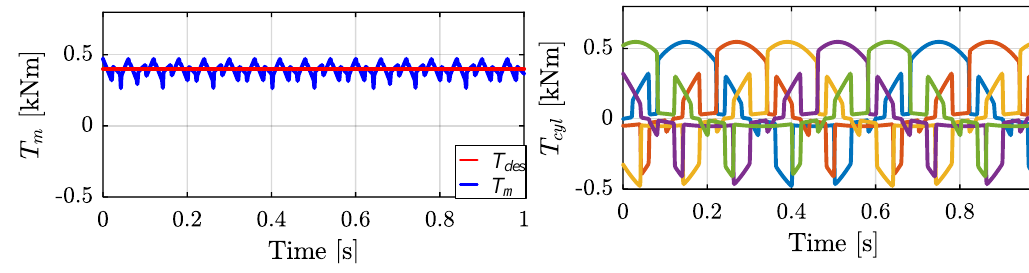
Figure 9. Example of DDM operation with